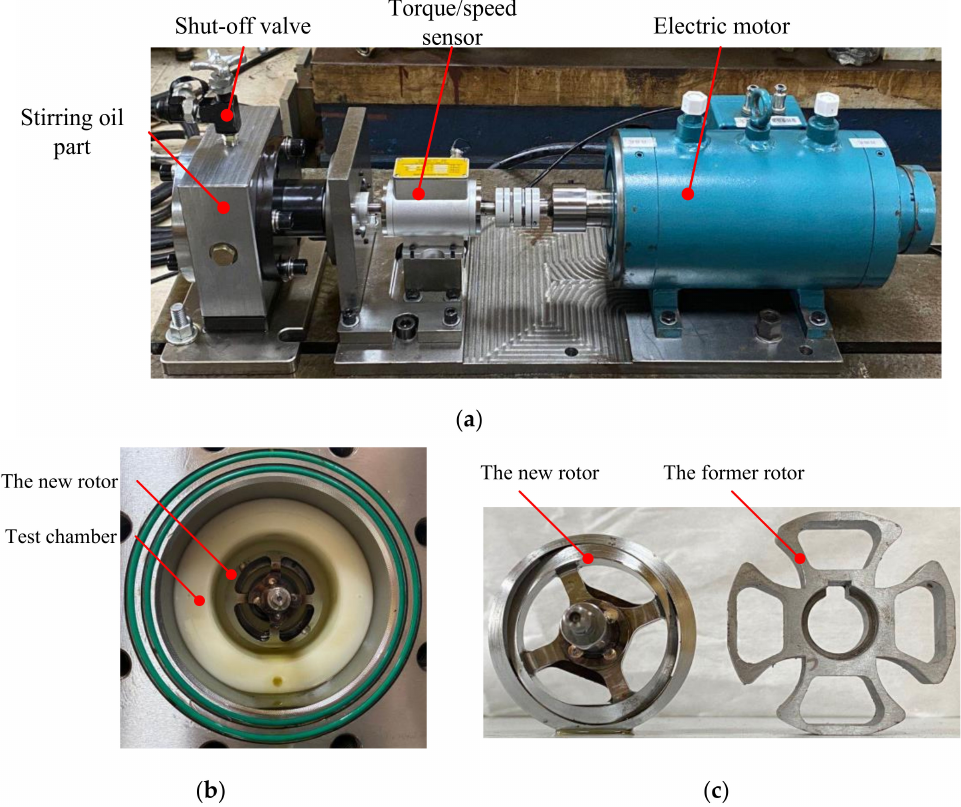
Figure 11. Test rig of the churning loss: ( a ) Overview of the test rig; ( b ) Details of the stirring oil part; ( c ) Comparison of the two